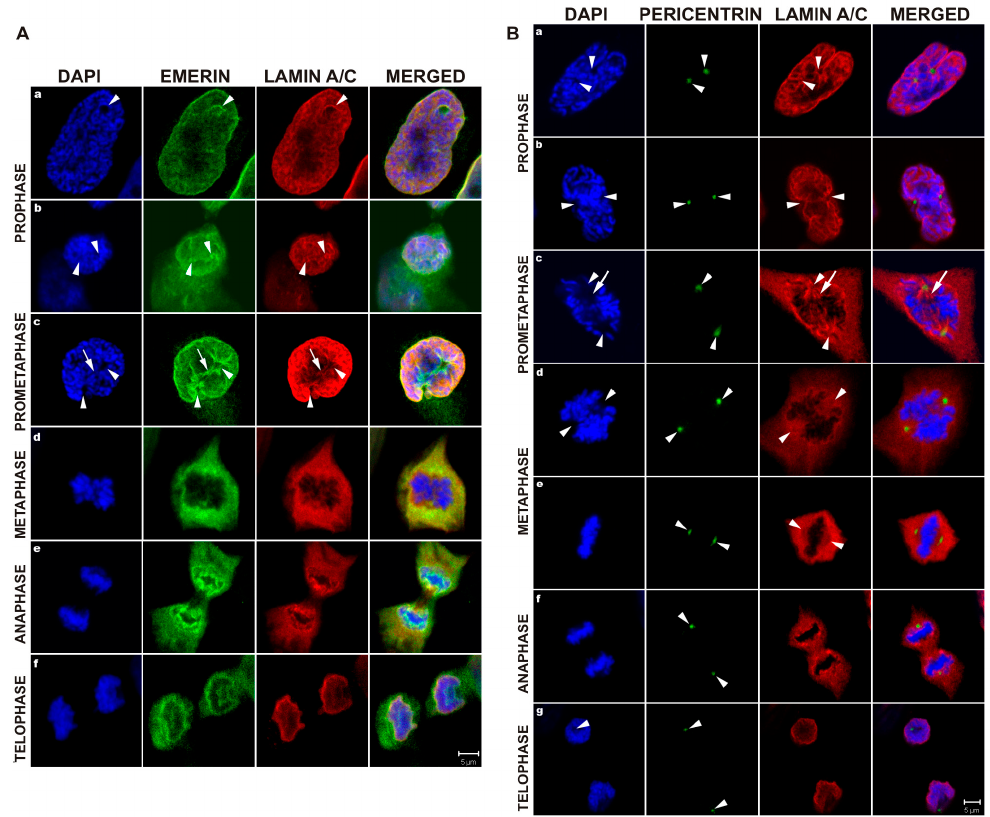
Figure 3. Cell cycle-dependent distribution of emerin and pericentrin in comparison to lamin A/C in HeLa cells. ( A ) Emerin colocalizes with lamin A/C during mitosis. Single confocal sections